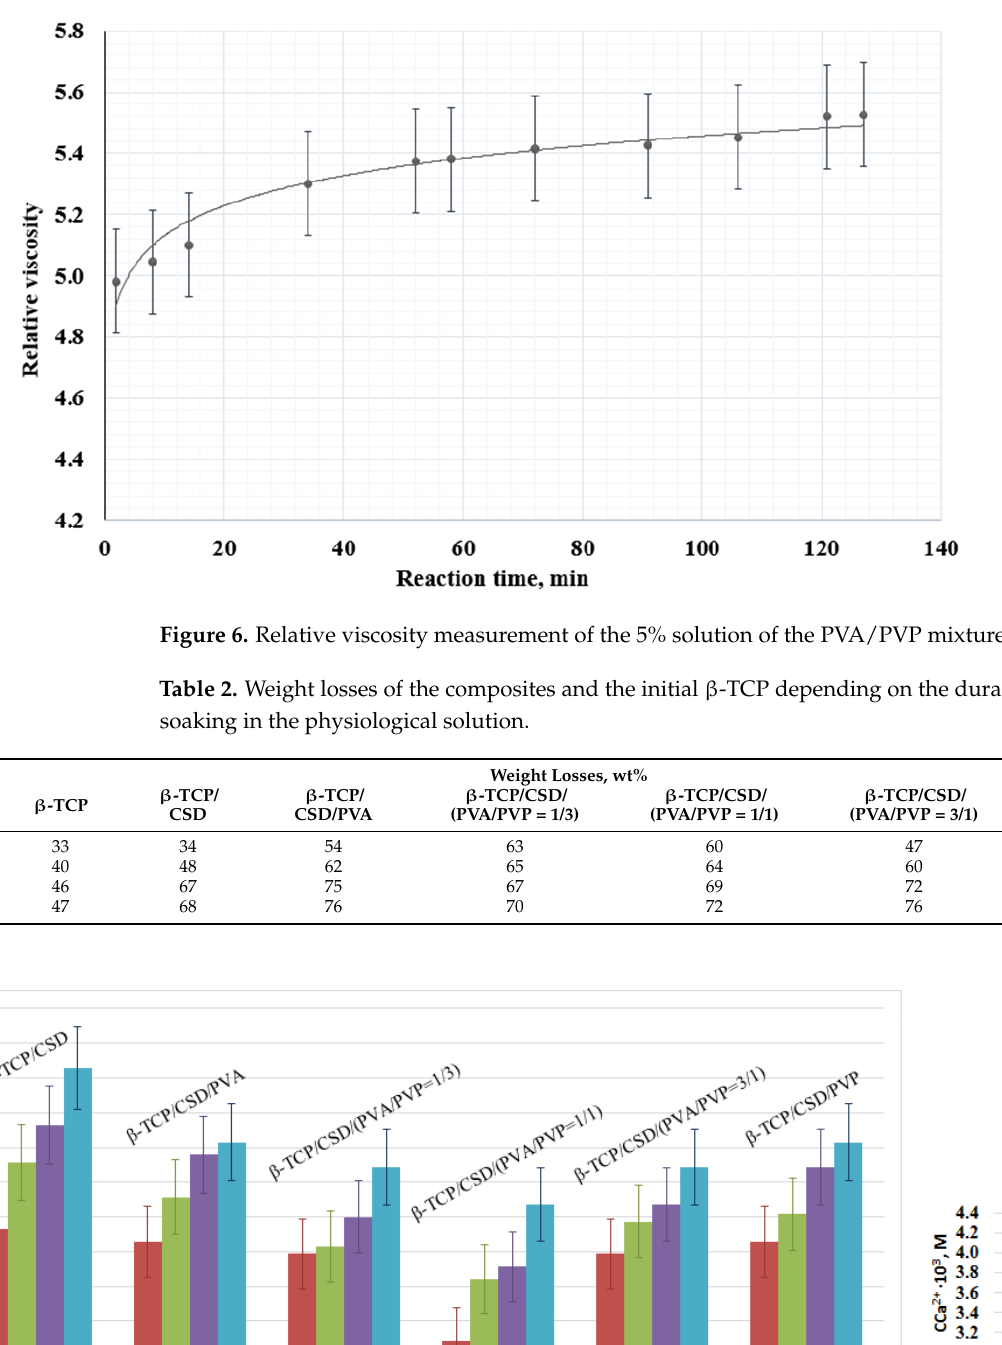
8 of 12 Figure 5. IR spectra of composite cement materials.